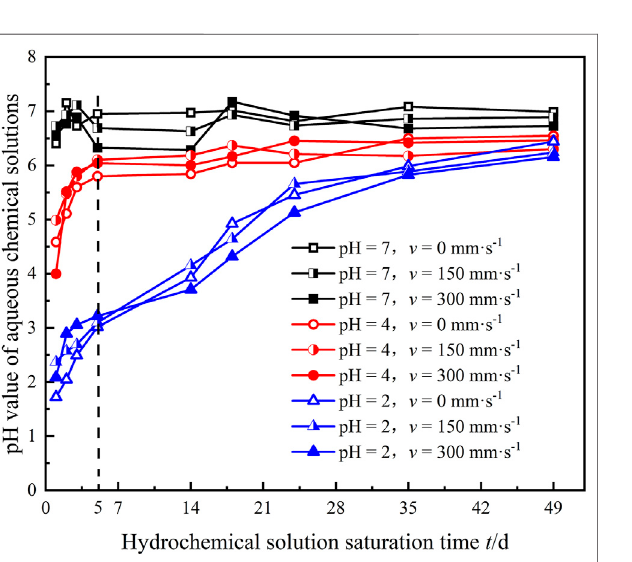
FIGURE9| Time-dependentvariationcurveofthegraniteelasticvertical wave speed of granite during the test process.